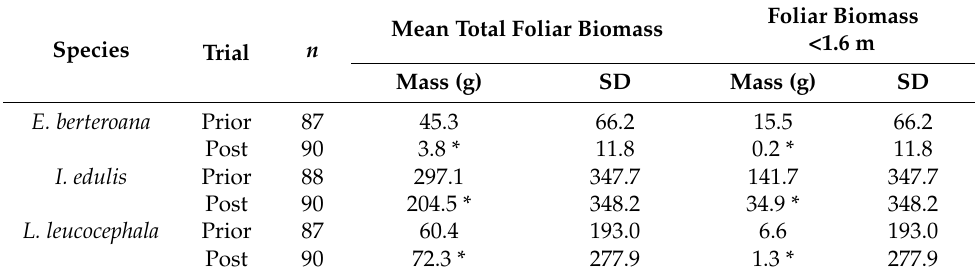
Table 1. Mean dry foliar biomass per individual trees (g), standard deviation (SD) and number of individuals sampled ( n ) prior to and post cattle browsing either mean total tree foliar biomass or foliar biomass harvested < 1.6 m on potential browse species E. berteroana , I. edulis and L. leucocephala . Significant differences ( p < 0.05) from prior to post browsing are denoted by an asterisk (*).